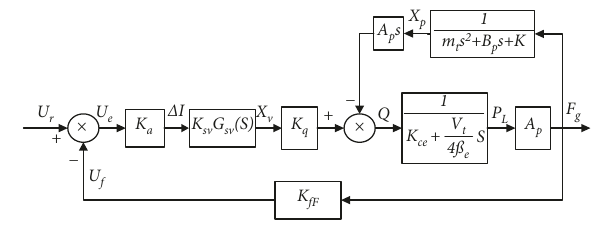
Figure 5: Block diagram of the control system.